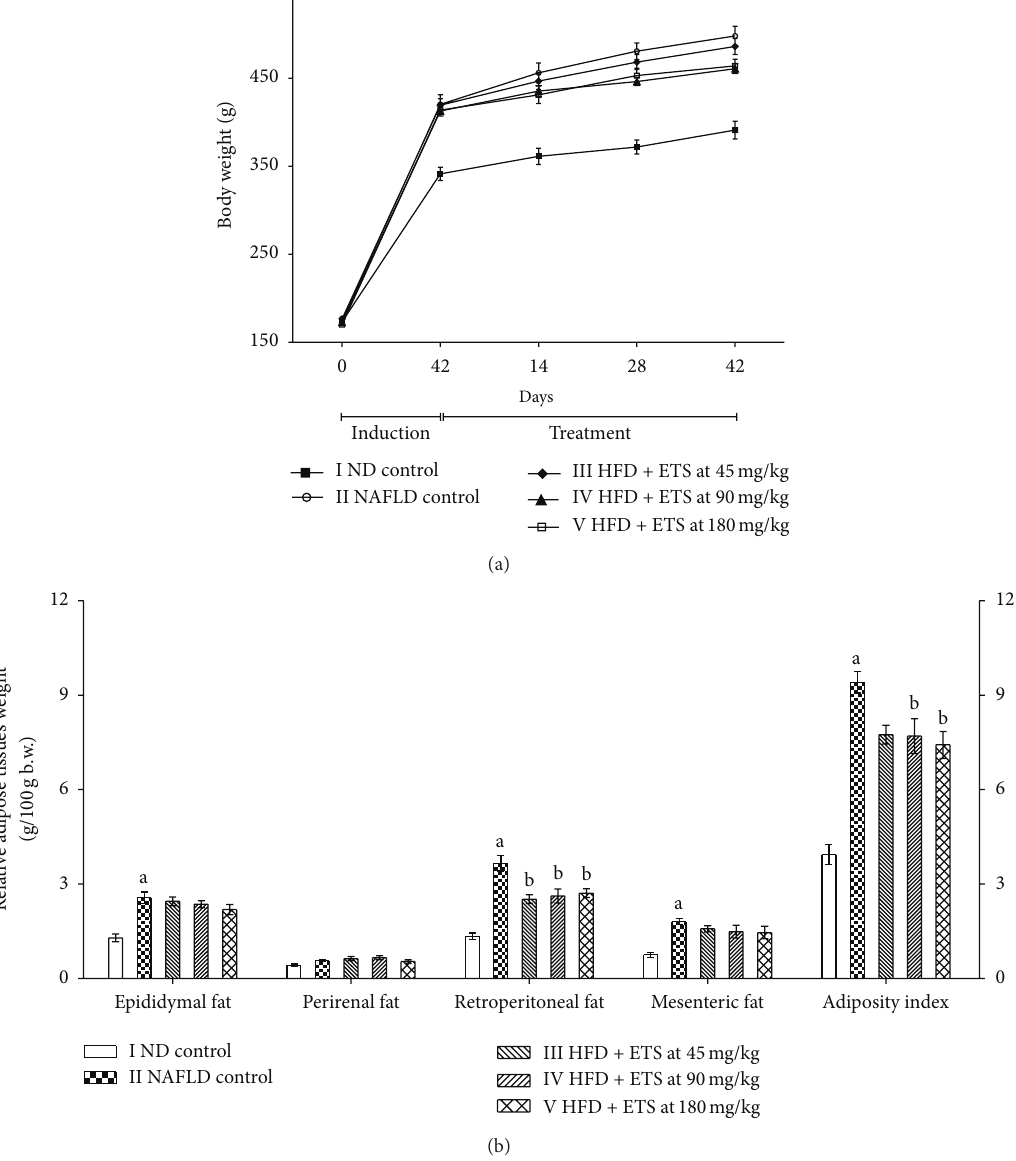
Figure 1: Effect of ETS treatment on body weight and relative adipose tissue weights in high fat diet fed rats. (a) Body weights; (b) relative adipose tissue weights. Rats were orally treated by high fat diet with or without ETS daily for 6 weeks, after induction of NAFLD by HFD feeding for 6 weeks. Values are expressed as Mean ± SEM; 𝑛 = 6 ; a 𝑃 ≤ 0.05 , NAFLD control vs ND control, b 𝑃 ≤ 0.05 , treated groups